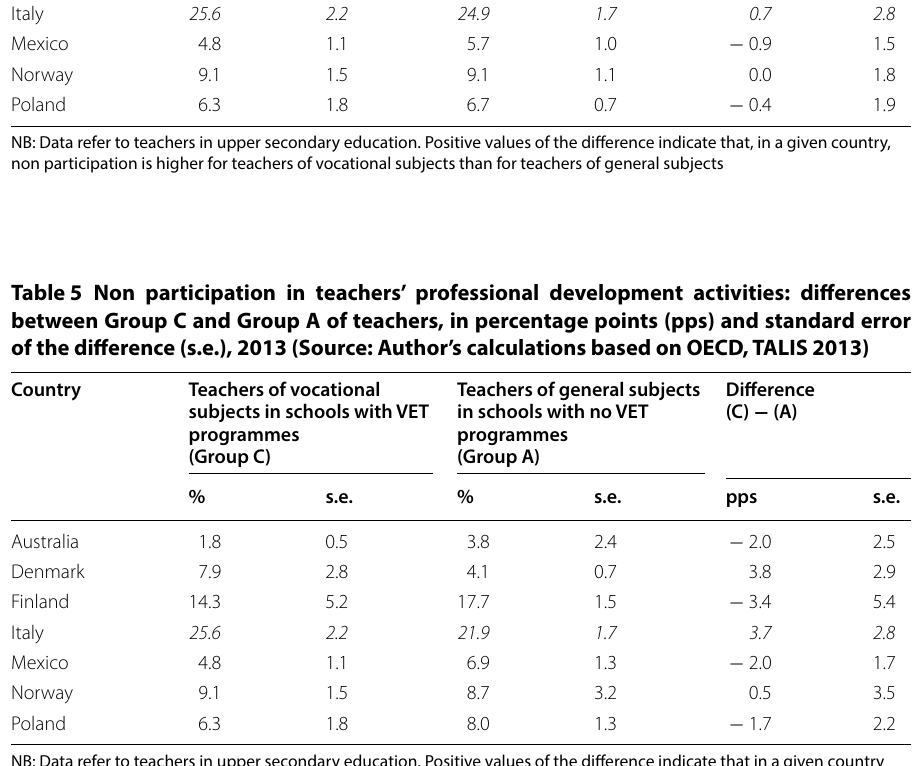
NB: Data refer to teachers in upper secondary education. Positive values of the difference indicate that, in a given country, non participation is higher for teachers of vocational subjects than for teachers of general subjects